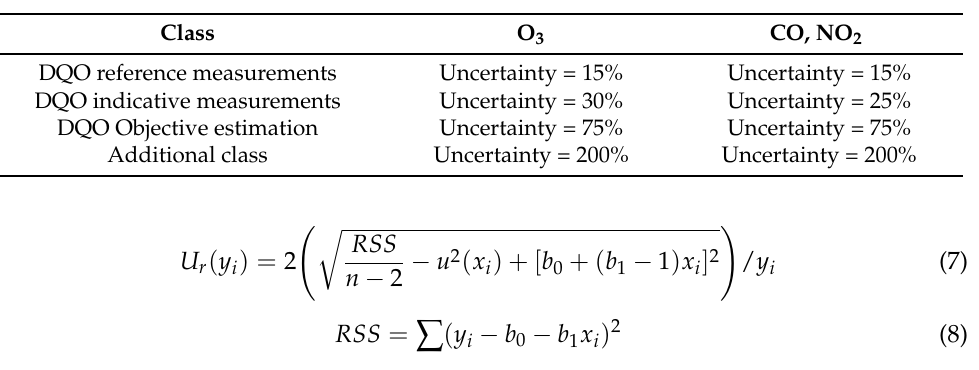
Table 5. Data quality objectives (DQO) of the European Directive [2].